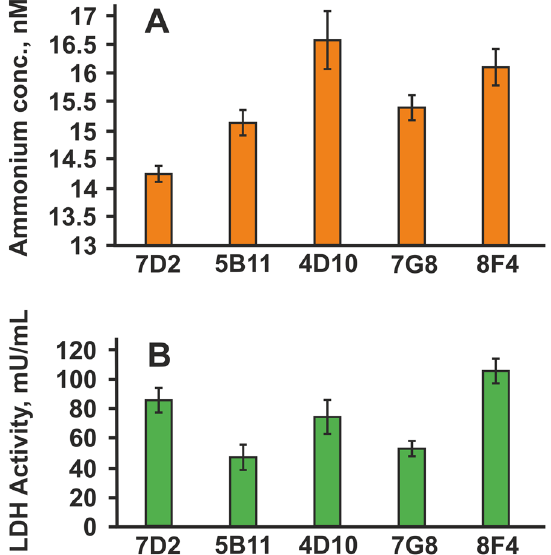
Table 1 Evaluation of IgG production in stably transfected CHO DG44 clones Clones 4D10 Concentration of Ig, μg/ml